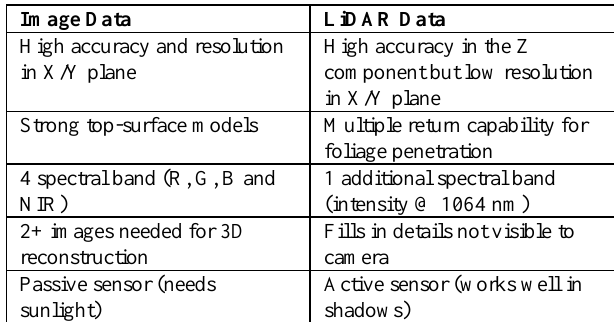
Table 2: Aerial image data versus LiDAR data -